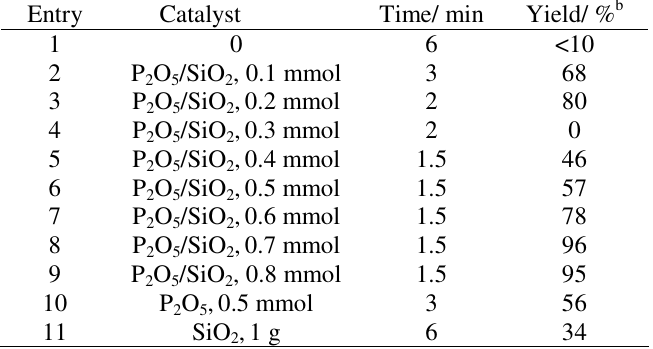
Table 2. The amounts of catalyst optimization for the synthesis of 3,3 ′ -benzylidene- 4,4 ′ - epoxydicoumarin